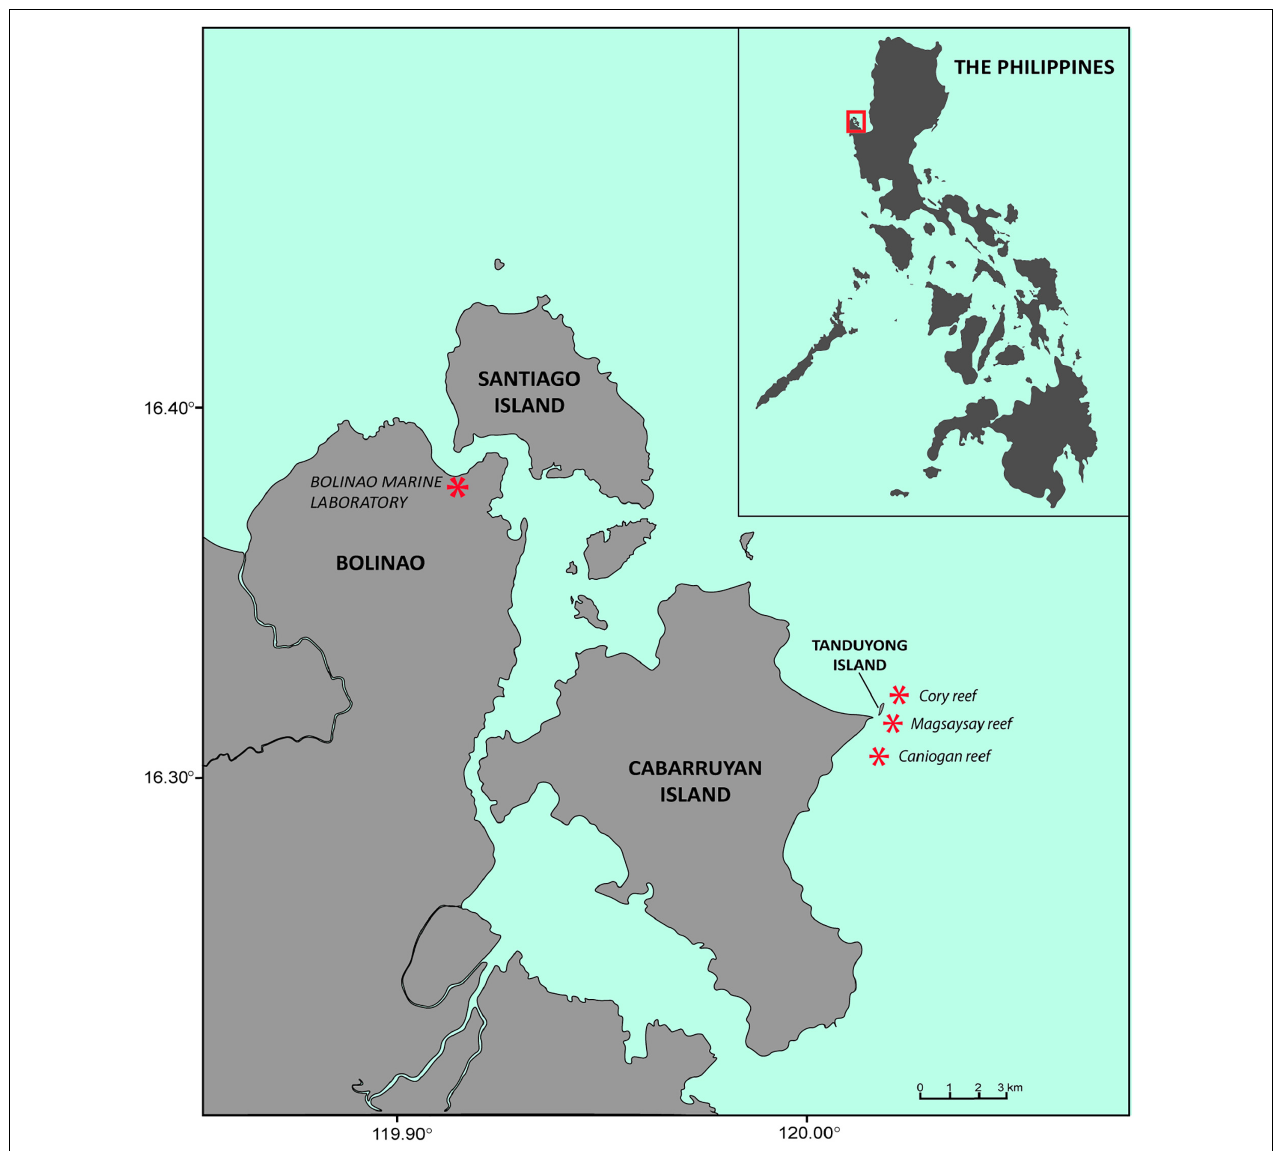
FIGURE 1 | Location of coral restoration site at Magsaysay reef and Bolinao Marine Laboratory in Northern Luzon, Philippines.